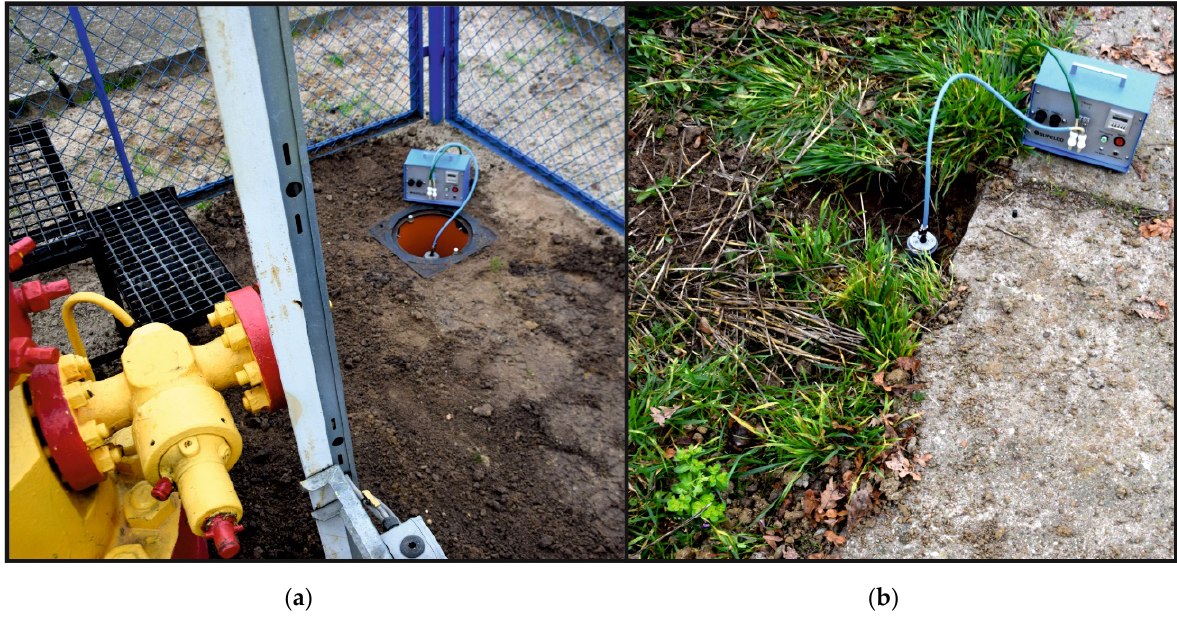
Figure 10. Soil gas sampling from a monitoring well located within the B-28 well pad: ( a ) from a monitoring well located within the B-28 well pad; ( b ) from a monitoring well located within 35 m of the B-28 wellhead.